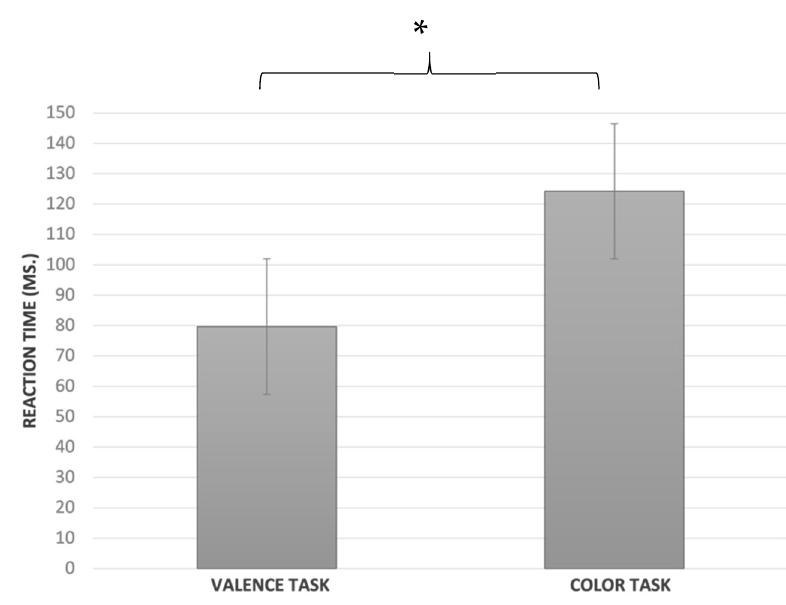
Figure 7. Switch cost in the Valence and Color tasks; * p = 0.028.